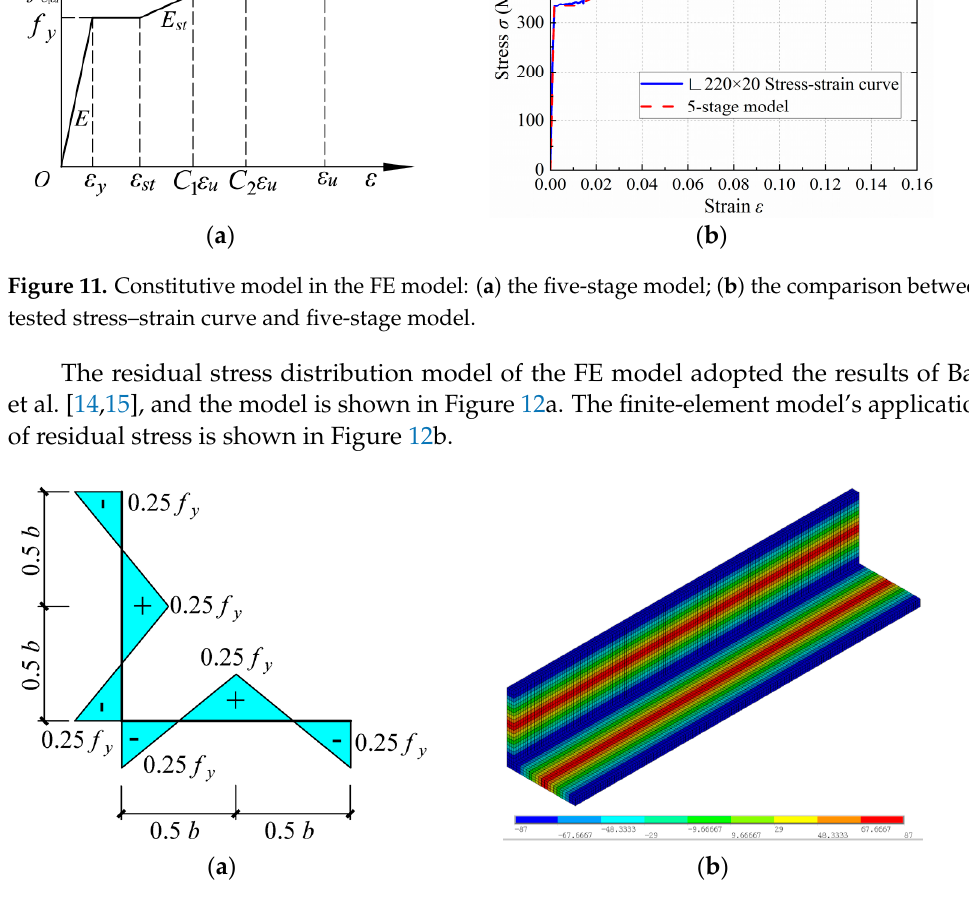
Figure 12. The residual stress: ( a ) the residual stress distribution model; ( b ) the finite-element model applied residual stress.